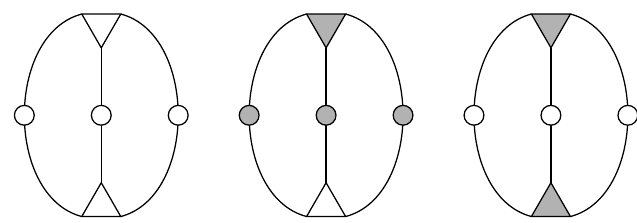
blocks to form a genus 2 surface. Shaded triangles correspond N